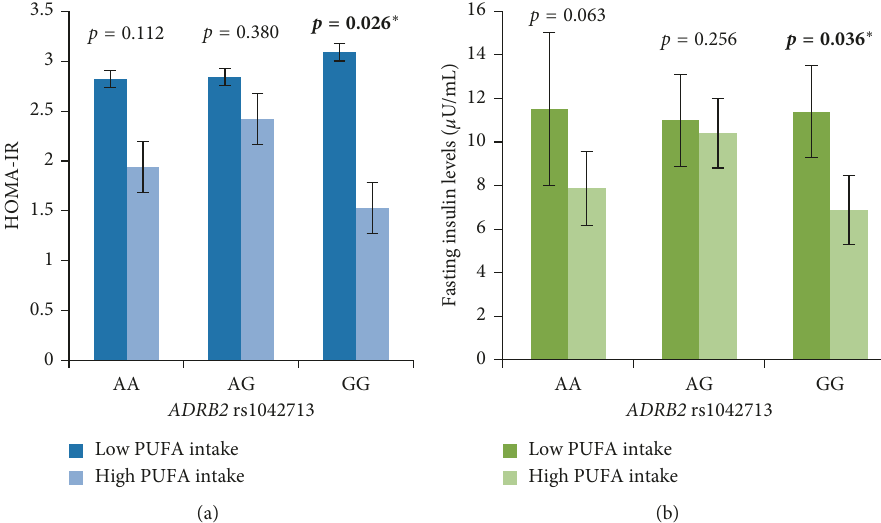
p 0 . 05 was considered statistically significant. SFA: saturated fatty ∗ <